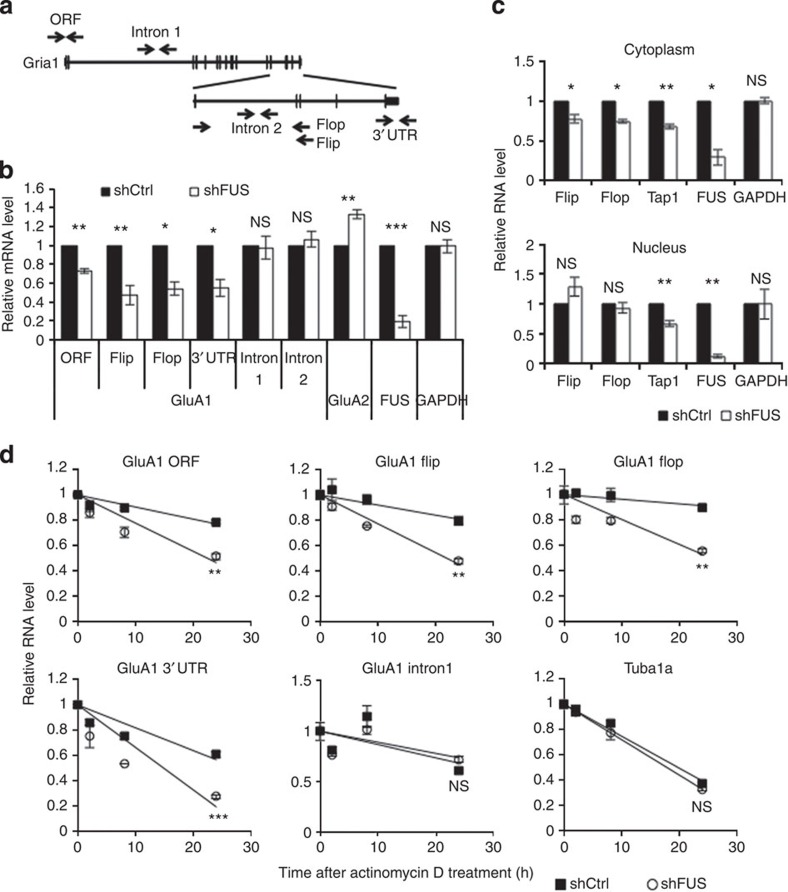
GluA1 mRNA stability is reduced upon FUS depletion.(a) Location of GluA1 qPCR primers used for quantification of different forms of GluA1 transcripts. Primer pairs for intron 1 and intron 2 detect only primary (unspliced) GluA1 transcripts, whereas primer pairs, ORF, flop, flip and 3′UTR detect spliced mature mRNAs. (b) Cultured cortical neurons were transduced by lentiviruses expressing shCtrl or shFUS as described in Fig. 1a. Total RNA was extracted and used for qRT–PCR using the primers described in a and the primers for FUS and GAPDH (ORF: n=3, t=10.12, **P=0.0096; flip: n=4, t=5.902, **P=0.0097; flop: n=3, t=6.391, **P=0.024; 3′UTR: n=3, t=4.985, *P=0.038; intron1: n=4, t=0.2265, P=0.8353; intron 2: n=3, t=0.7341, P=0.54; FUS: n=3, t=12.75, **P=0.0061; GAPDH: n=4, t=0.1446, P=0.89, paired t-test). (c) Cytoplasmic and nuclear RNA were separately prepared from control and FUS knockdown cortical neurons and RNA from each fraction was subjected for qRT–PCR as in b (cytoplasm, flip: t=5.856, *P=0.028; flop: t=5.966, *P=0.027; Tap1: t=17.81, **P=0.0031; FUS: t=9.368, *P=0.011; GAPDH: t=1.027, P=0.4124; nucleus, flip: t=1.831, P=0.21; flop: t=0.8251, P=0.50; Tap1: t=6.529, **P=0.023; FUS: t=26.23, **P=0.0014; GAPDH: t=1.818, P=0.2107, n=3, paired t-test). (d) mRNA stability was measured in the control and FUS knockdown primary cortical neurons treated with 10 μg ml−1 actinomycin D by qRT–PCR using primer sets indicated above each graph. The RNA level relative to pretreatment in equal amount of total RNA was plotted against time after the treatment. Residual RNA levels at 24 h were compared (n=3 each, GluA1 ORF: t=8.184, **P=0.0012; GluA1 flip: t=5.500, **P=0.0053; GluA1 flop: t=7.365, **P=0.0018; GluA1 3′UTR: t=10.41, ***P=0.0005; GluA1 intron1: t=1.527, P=0.20; Tuba1a: t=2.654, P=0.057, unpaired t-test). GAPDH, glyceraldehyde 3-phosphate dehydrogenase; NS, not significant.